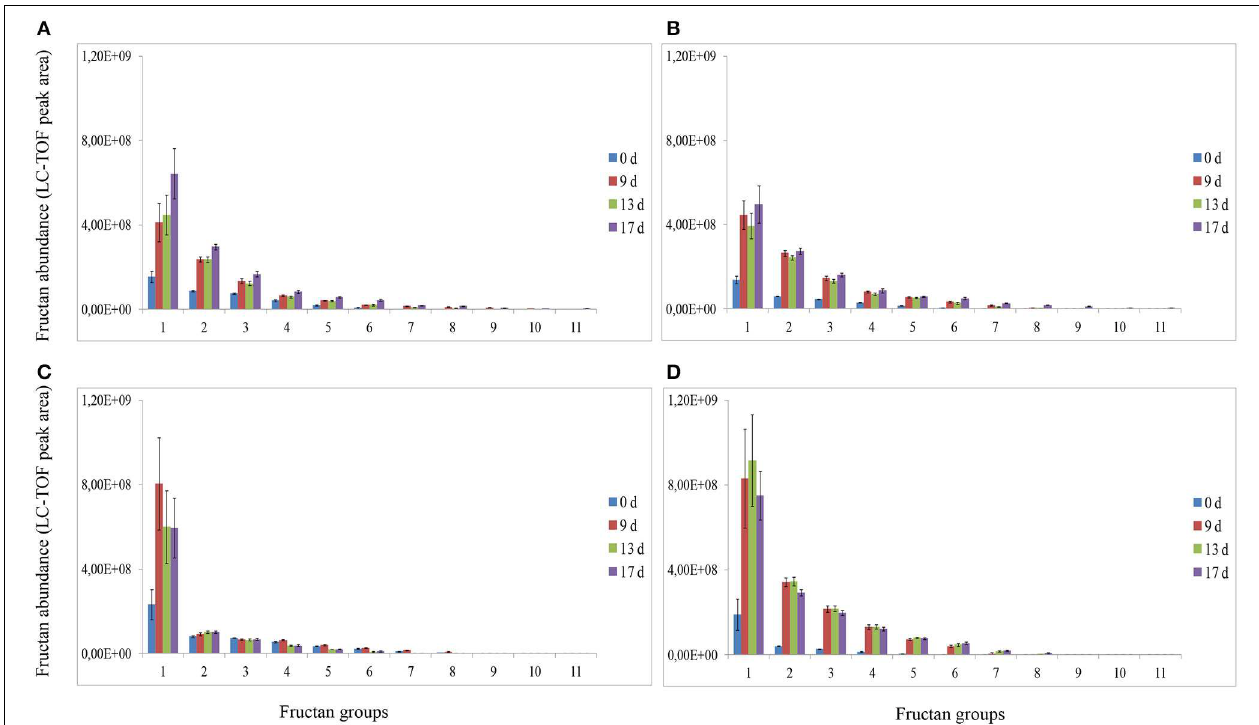
and (11) DP = 63–70. Changes in fructan DP and composition in the (A) green tissues (top) of “Veyo,” (B) top of “Falster,” (C) roots of “Veyo,” and (D) roots of “Falster.” Fructan DP and composition on d 0, 9, 13, and 17 of cold acclimation are shown. Relative quantification of fructan oligosaccharides and polysaccharides was carried out using LC-ESI-TOF-MS. Data represent the mean ± SE, obtained from each